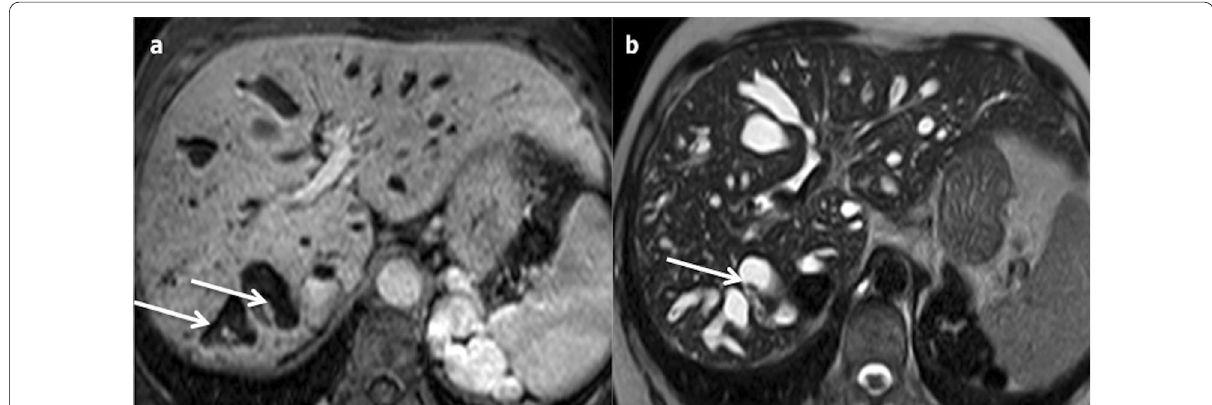
Fig. 12 Caroli syndrome in a 53-year-old female. a Axial magnetic resonance imaging on portal venous phase shows peripheric fusiform dilated bile duct, hyperintense on axial T2-weighted magnetic resonance imaging ( b ), with the specific “central dot sign” (arrows). Note the presence of spleno-renal shunts due to portal hypertension